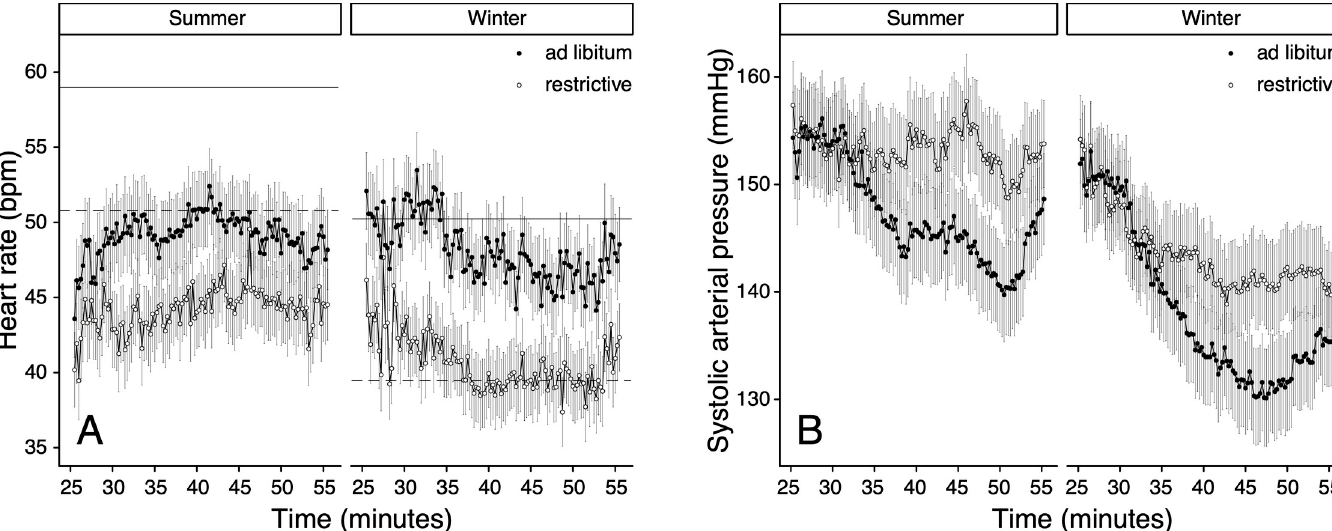
Fig 5. The influence of alternating type of PUFA supplementation (omega-6 FA (n = 6) or omega-3 FA (n = 5) rich pellets) on heart rate (A) and direct systolic arterial pressure (B) in two different seasons (summer vs. winter) in female red deer ( Cervus elaphus , n = 11). Heart rate and SAP were measured from minute 25 to 55 after anaesthesia induction (means ± standard error of the mean). Baseline heart rate values for omega-3 (solid) or omega-6 (dashed) enriched pellet intake are represented by a horizontal line.